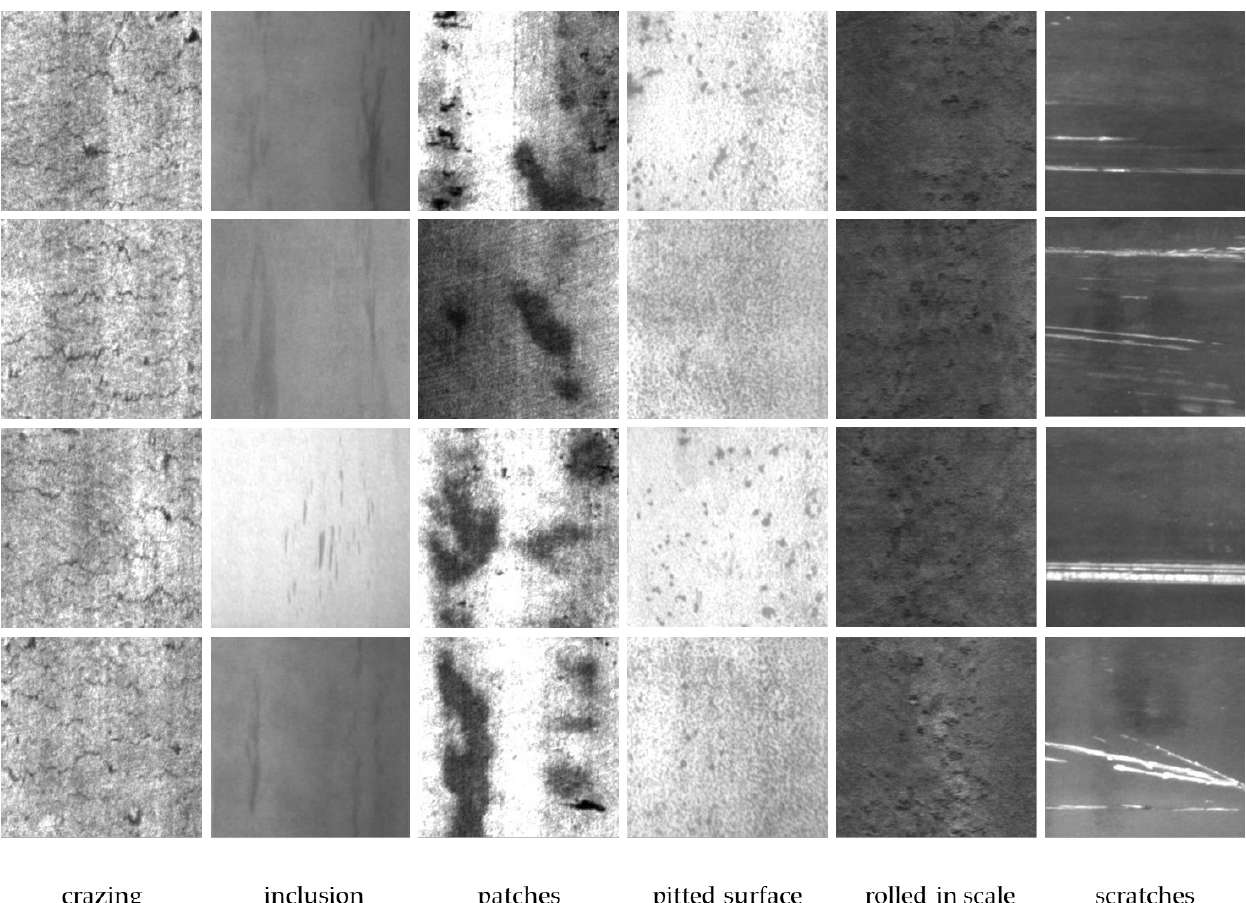
Figure 2. Surface defect samples in the NEU-DET dataset.